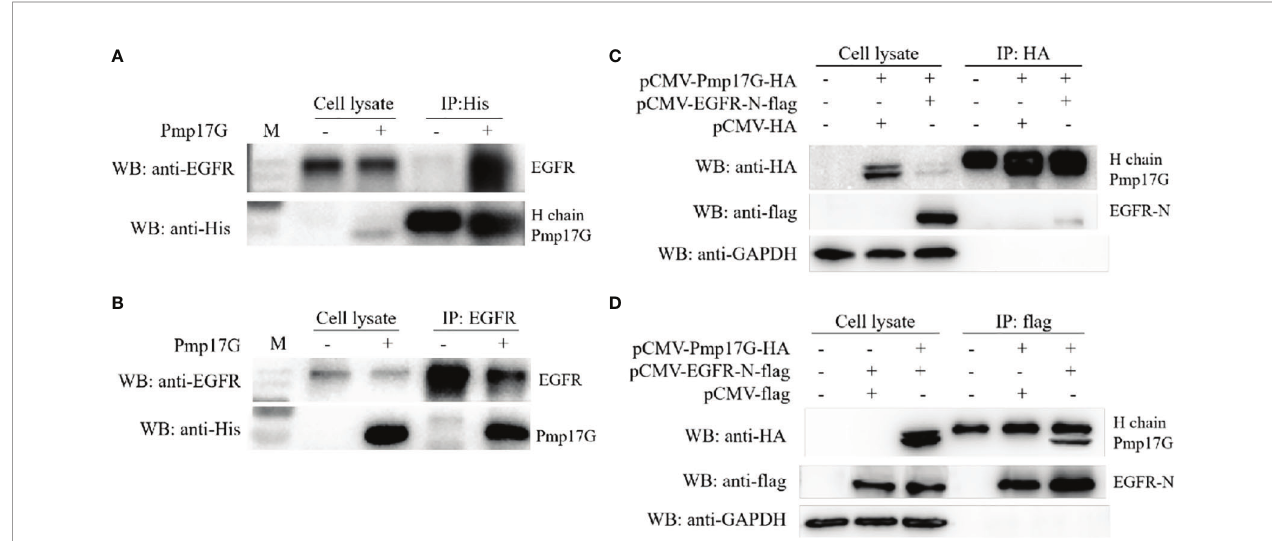
FIGURE 3 | Crosstalk of Pmp17G with EGFR. (A) Pmp17G was incubated with HeLa 229 cells for 2 h, immunoprecipitated with anti-His mAbs, and then reacted with anti-EGFR mAbs and anti-His mAbs. (B) After incubation with HeLa 229 cells, IP was assayed with anti-EGFR mAbs, and then, Pmp17G-recognized EGFR was identi fi ed with anti-His mAbs and anti-EGFR mAbs using Western blots. (C) Co-expression of Pmp17G and EGFR in HeLa 229 cells. HeLa 229 cells were transfected with pCMV-Pmp17G-HA and pCMV-EGFR-N- fl ag plasmids, reacted with anti-HA antibody for IP, and then incubated with anti- fl ag and anti-EGFR mAbs by Western blots. (D) Co-expression of Pmp17G and EGFR in HeLa 229 cells was evaluated by Co-IP. HeLa 229 cells were transfected with pCMV-Pmp17G-HA and pCMV-EGFR-N- fl ag plasmids, immunoprecipitated with anti- fl ag antibody, and then identi fi ed with anti- fl ag and anti-EGFR mAbs using Western